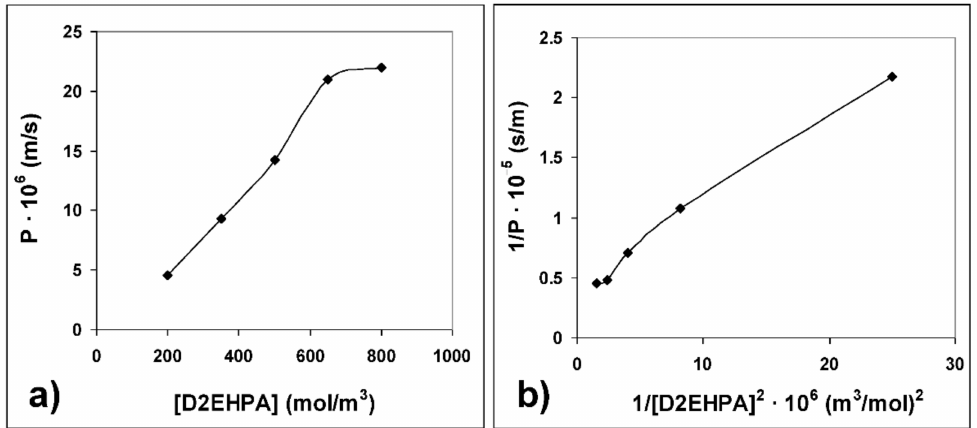
Figure 5. ( a ) E ff ect of the carrier concentration in the membrane phase on Co(II) initial permeability; ( b ) inverse of Co(II) initial permeability versus the inverse of the square of carrier concentration in the membrane phase.